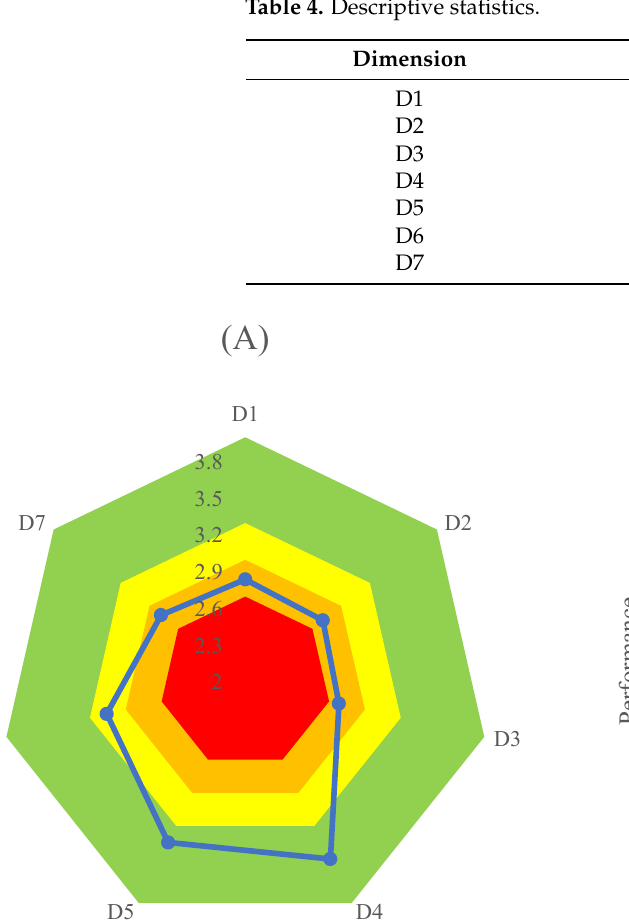
Figure 1. The quadrants in the standard IPA plot.